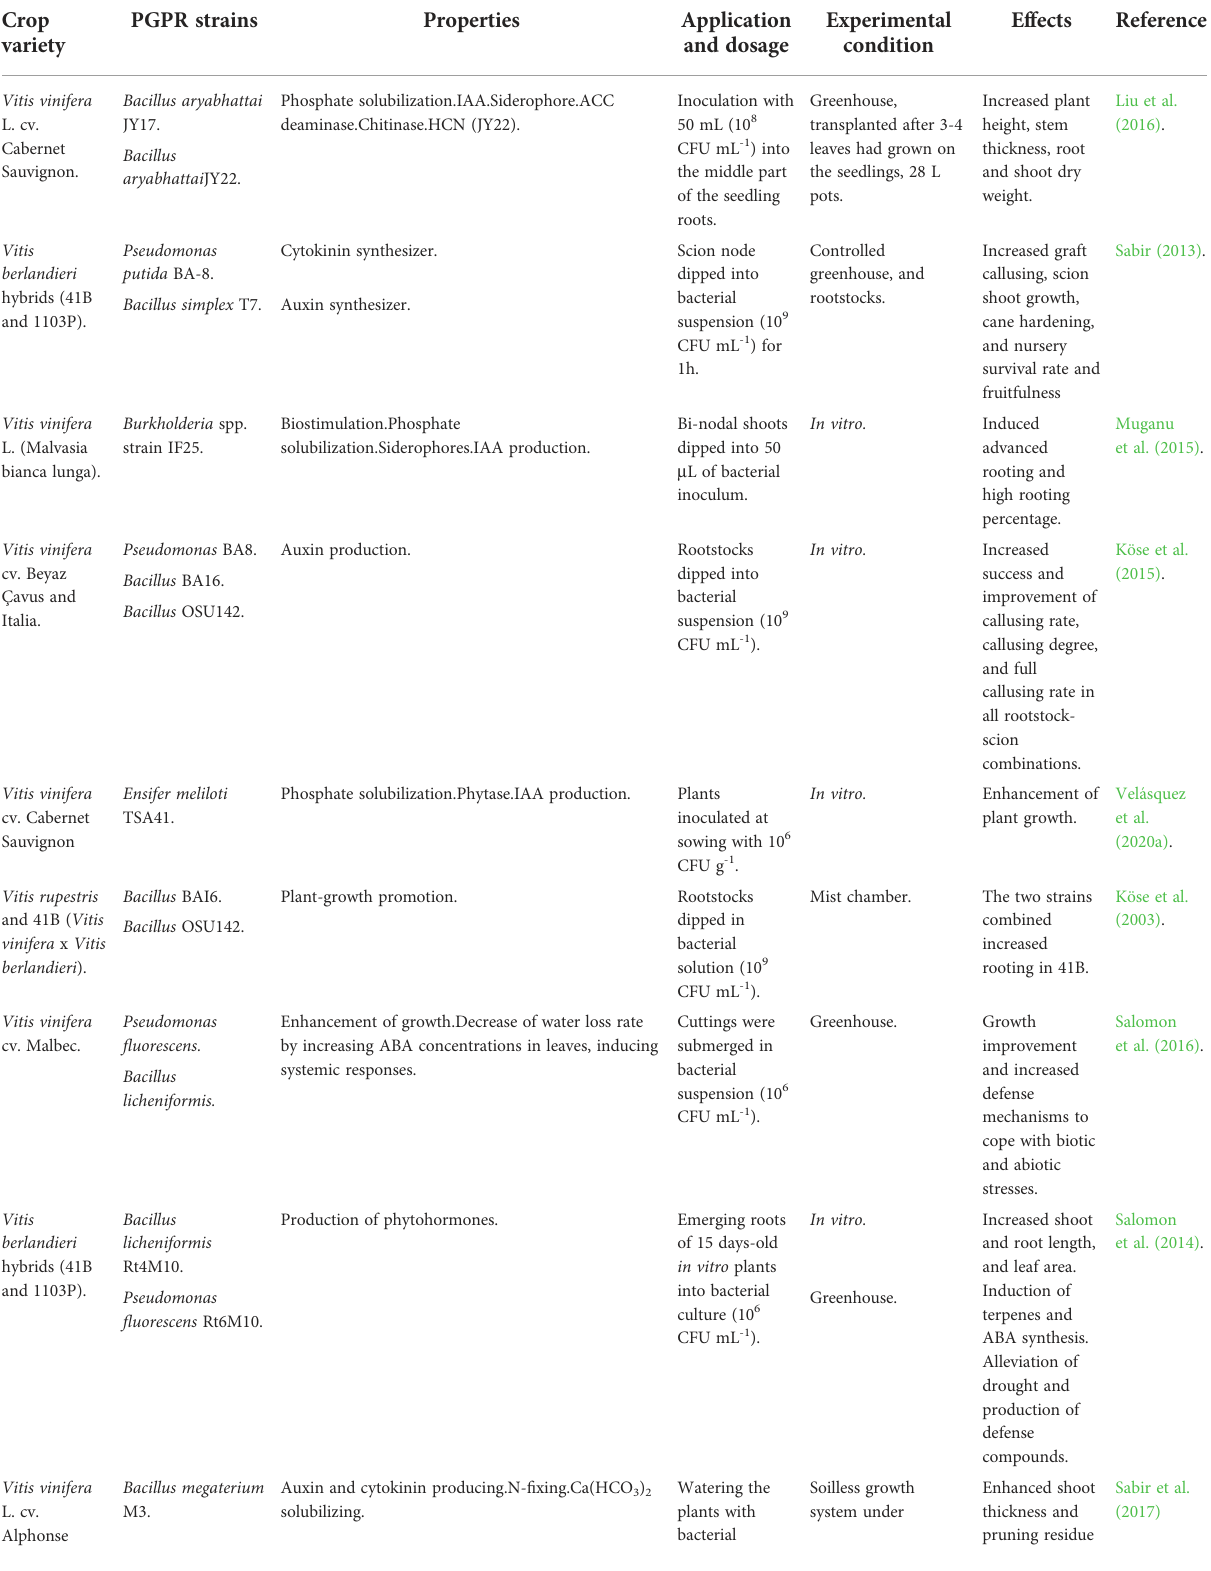
TABLE 5 An overview of the main effects of plant-growth-promoting rhizobacteria (PGPR) applied in